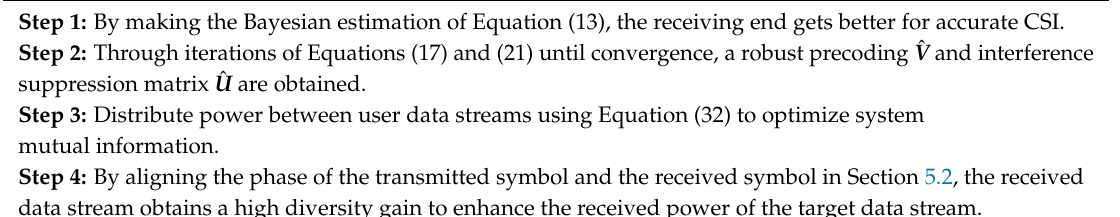
Algorithm 1. Joint interference and phase